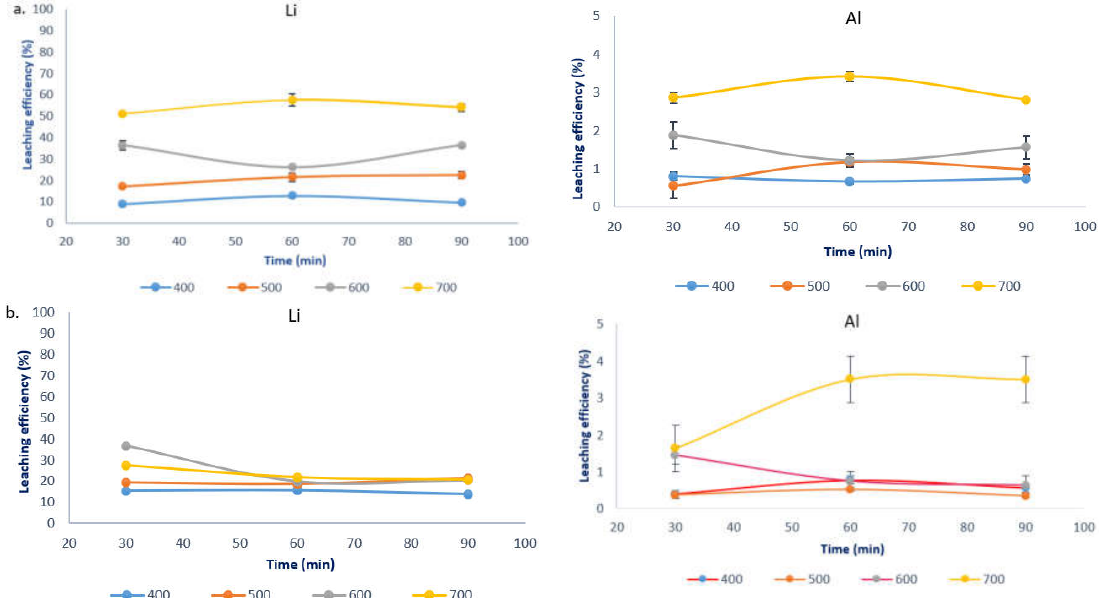
Figure 1. The effect of thermal treatment temperature and time on Li and Al leaching efficiency: ( a ) pyrolysis and ( b ) incineration (Leaching condition: L/S ratio = 20:1 mLg −1 , 80 °C, 300 rpm, and 3 h).